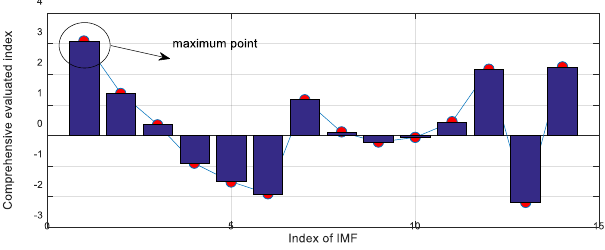
Figure 26. Selection of IIM with (ECEEMDAN-CF).